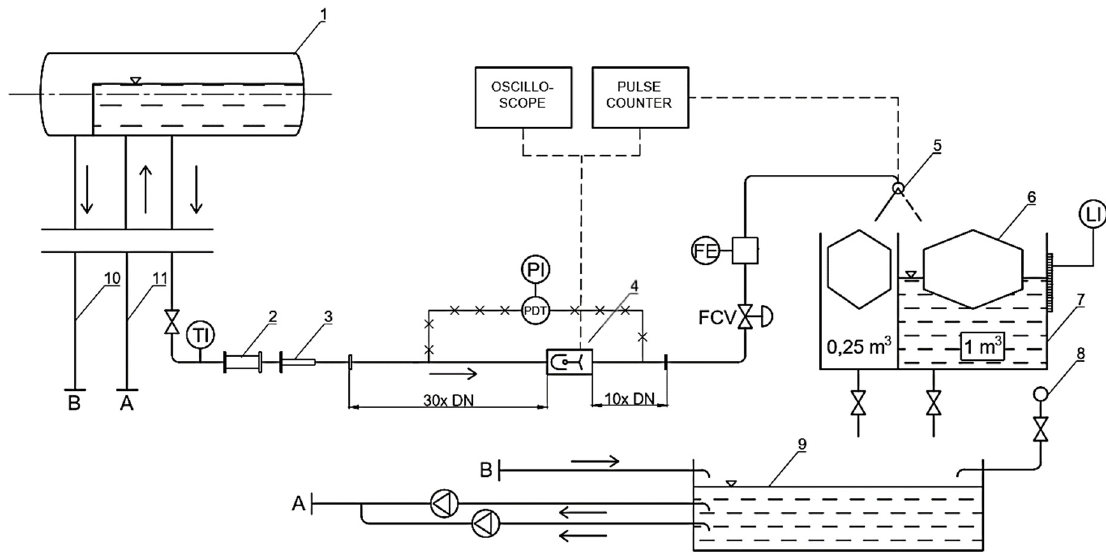
Figure 6. Water calibration stand diagram; 1—water supply reservoir, 2—in-line sight glass, 3—telescopic compensator, 4—mechanical oscillator flowmeter, 5—flow diverter, 6—fixed buoys which increase resolution of level measurement, 7—measurement tanks, 8—mains, 9—storage tank, 10—overflow pipe, 11—discharge line, TI—temperature indicator, PDT—pressure difference transmitter, PI—pressure indicator, FCV—flow control valve, FE—electromagnetic flowmeter, LI—level indicator. Dashed lines denote electrical connections. X-hatched lines denote pressure signal connections.